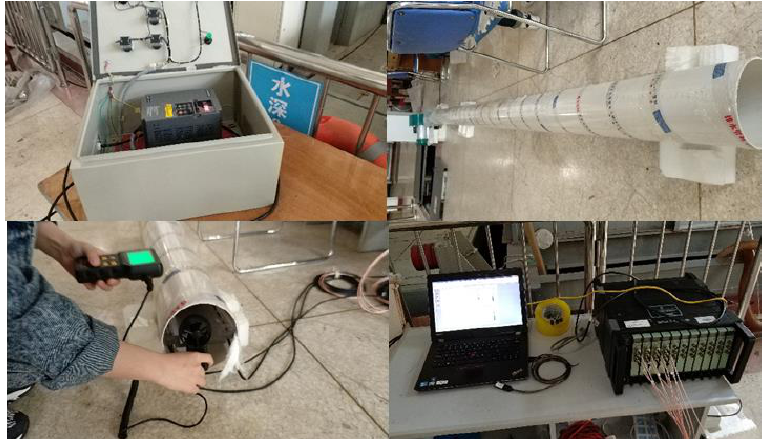
Figure 10. Experimental setup.